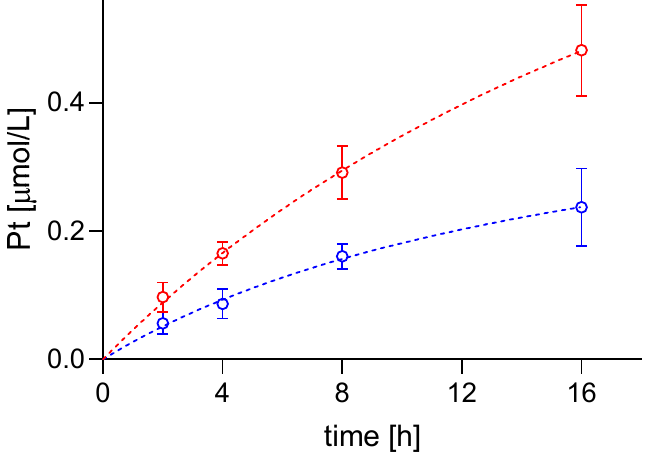
Figure 3. Timeline of cisPt uptake by -- ● -- A24 and -- ● -- A24dPt8 cells after incubation with 30 µM cisPt.